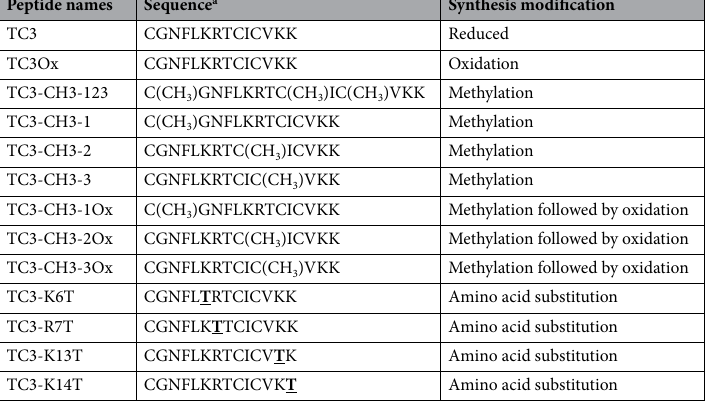
Table 1. List of peptides synthetized and used in this study. a Amino acids substitutions are underlined and in bold